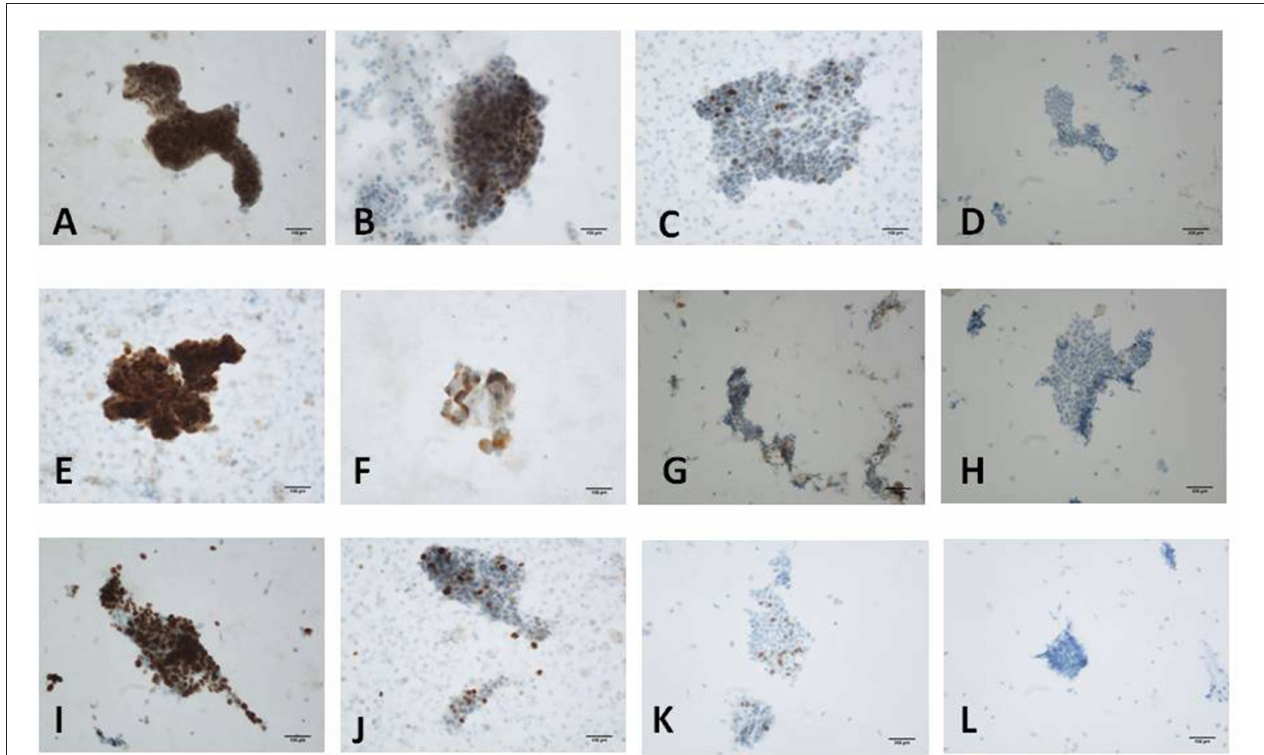
FIGURE 2 | Immunostaining for p53, Ki-67 and CA125 protein. (A) Scored 6 of p53 in moderately differentiated endometrioid carcinoma ( , 90%); (B) Scored 4 + + + of p53 in localized serous carcinoma ( , 40%); (C) Scored 2 of p53 in proliferative endometrium ( , 10%); (D) Scored 0 of p53 in atrophic endometrium (–). ++ + (E) Scored 6 of Ki-67 in moderately differentiated endometrioid carcinoma ( , 70%); (F) Scored 4 of Ki-67 in atypical hyperplasia with carcinogenesis ( , + + + + + + 30%); (G) Scored 3 of Ki-67 in proliferative endometrium